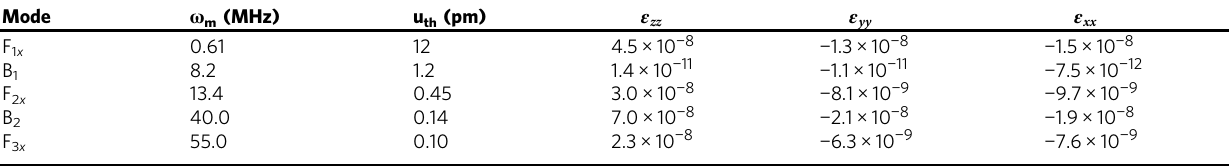
The QD is located 35nm away from the centre along the x -axis. Details of the geometry of the nanowire are given in Section IV 5. The strain values are given for a displacement of the top facet equal to the time-averaged displacement u th at T = 4.2K